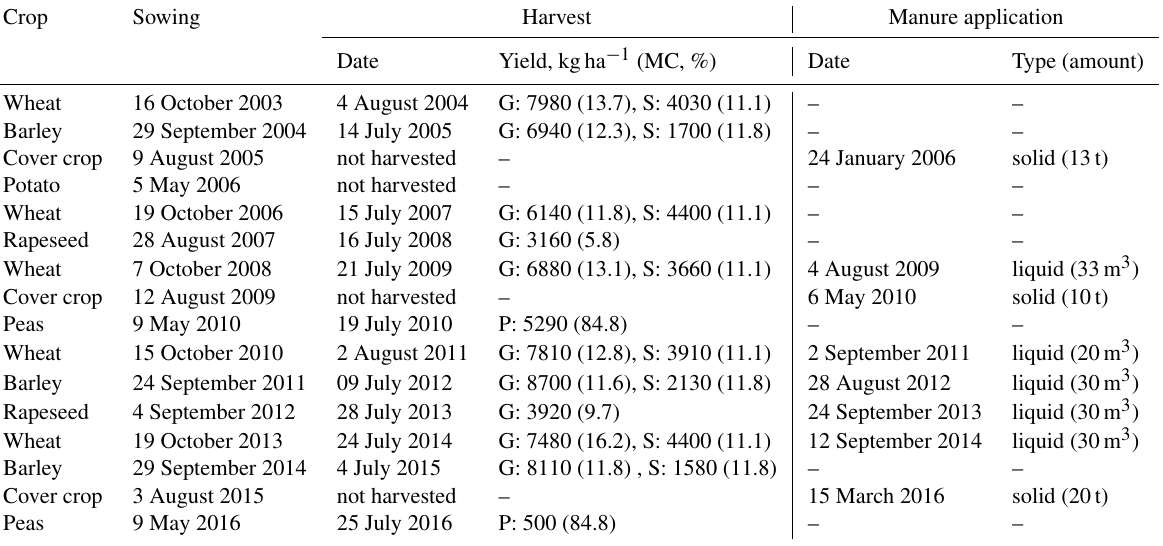
Table 1. Management information for all 16 crop seasons (defined as sowing of the current crop to sowing of the following crop) between 2003 and 2016 with crop type, sowing and harvest dates, and yield (G: grain, P: peas, S: straw). Moisture content of the harvested biomass (MC) is given in parentheses. If manure was applied during the crop season, the date, manure type and amount are given as well. Sowing